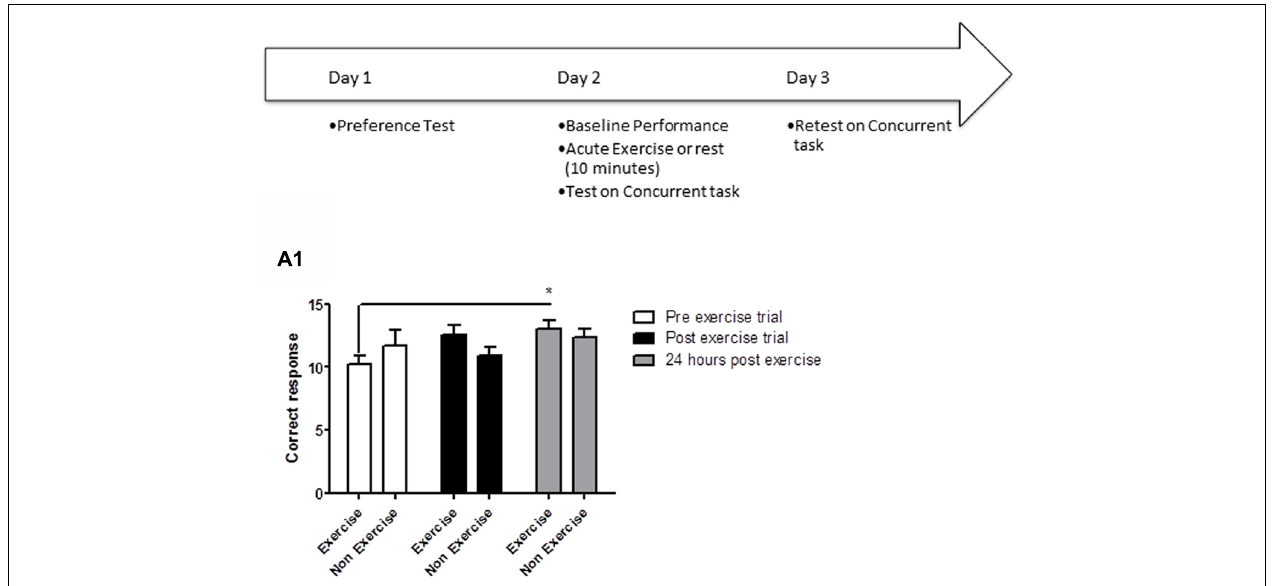
the concurrent discrimination task.The figure shows the number of correct response in the concurrent discrimination task conducted first prior to exercise, then immediately after exercise, and finally at 24 h after the exercise training. At 24 h post-exercise the animals in the exercise group were significantly improved compared to the pre exercise trial. * p < 0.05. Significant difference from pre exercise trial. n = 11/group, Error bars show ±